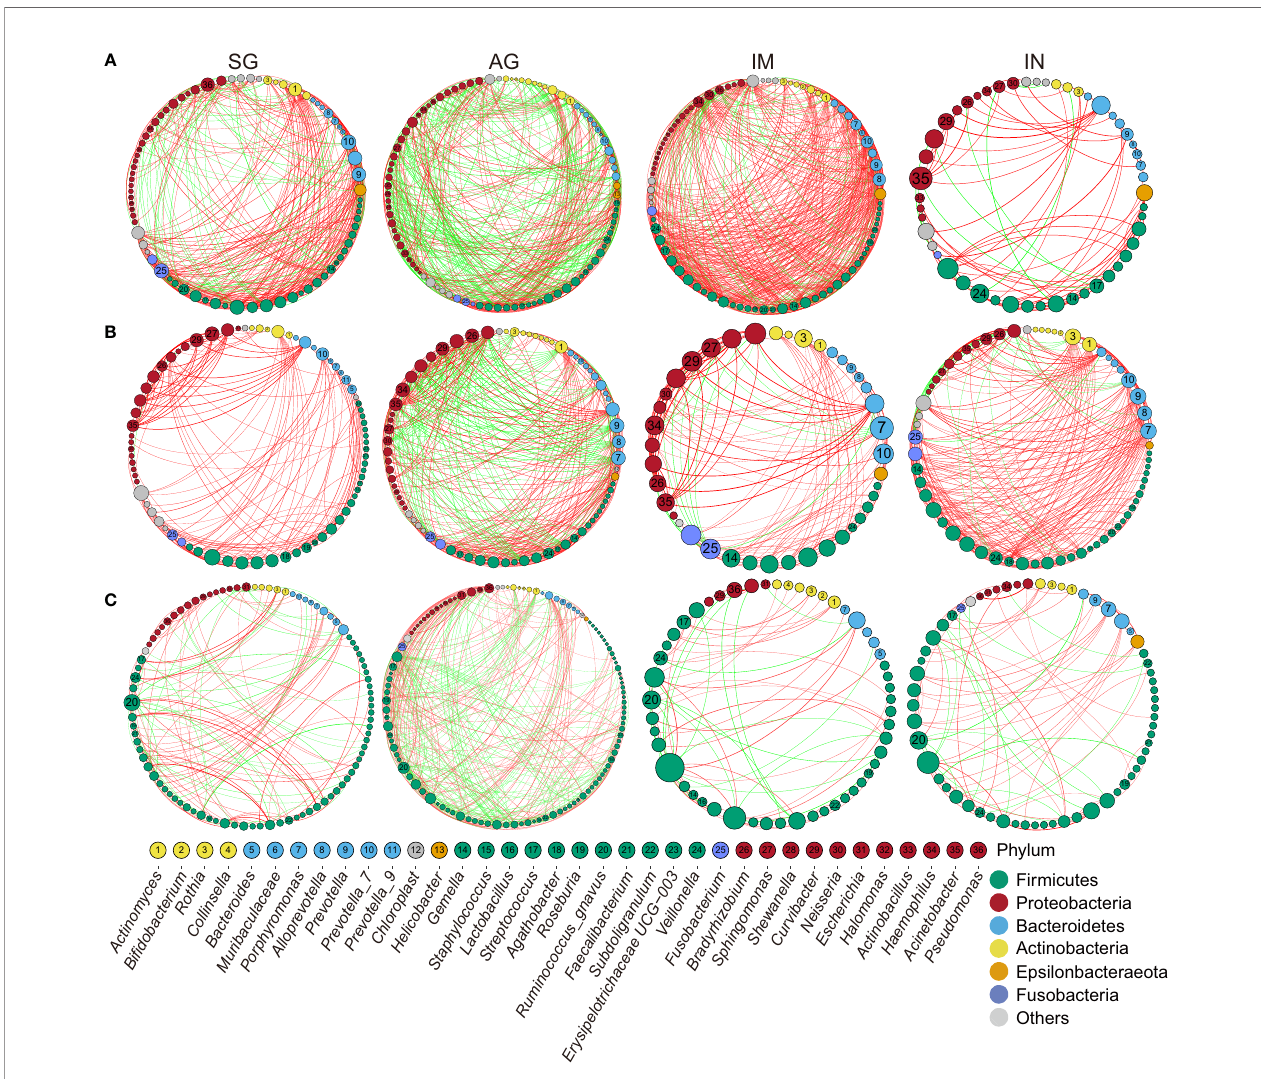
FIGURE 3 | Correlation networks of the gastrointestinal genus in different PLGC groups. (A) The interactions of bacteria in gastric biopsies in H. pylori -negative subjects with strengths > 0.8. (B) The interactions of bacteria in gastric juice with strengths > 0.8. (C) The interactions of bacteria in stool samples with strengths >0.5. The size of nodes corresponds to weighted node connectivity scores, and the nodes were colored by phylum. Red edges denote positive correlations and green edges denote negative